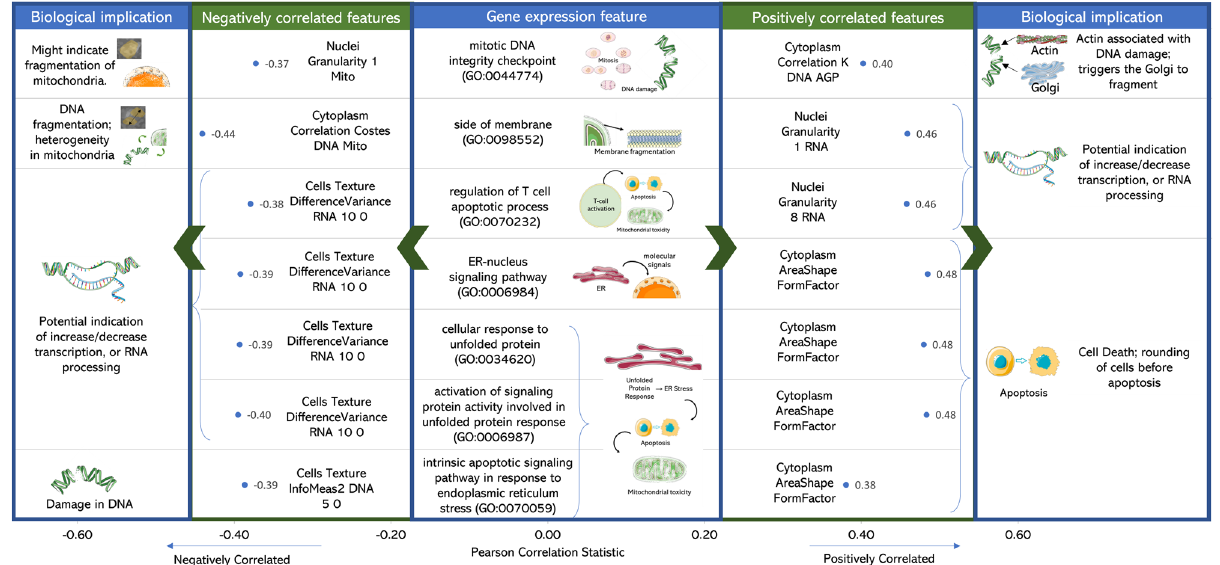
Fig. 5 Biological implication in mitochondrial toxicity of the cell painting features correlated to gene expression. Computational signi fi cance and biological implication in mitochondrial toxicity of the Cell Painting features that are most positively or negatively correlated to Gene Expression descriptors particularly unfolded protein response and endoplasmic reticulum stress (RNA variance and cell area shape), T cell apoptotic processes (mitochondrial granularity and DNA fragmentation) and side of the membrane (RNA granularity and heterogeneity in mitochondria). Further details in Supplementary Data 3. The Figure was partly generated using Servier Medical Art, provided by Servier, licensed under a Creative Commons Attribution 3.0 unported license.